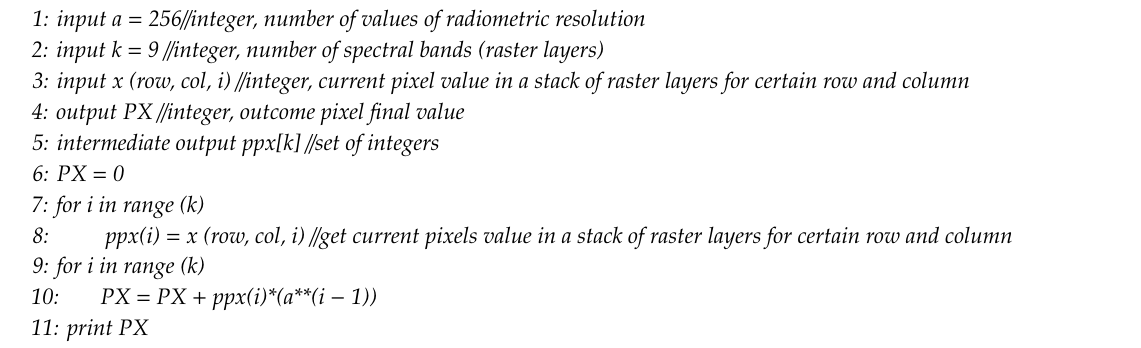
Algorithm 1 Reed-Solomon Pixel-Level Algorithm for Remote Sensing Data Fusion